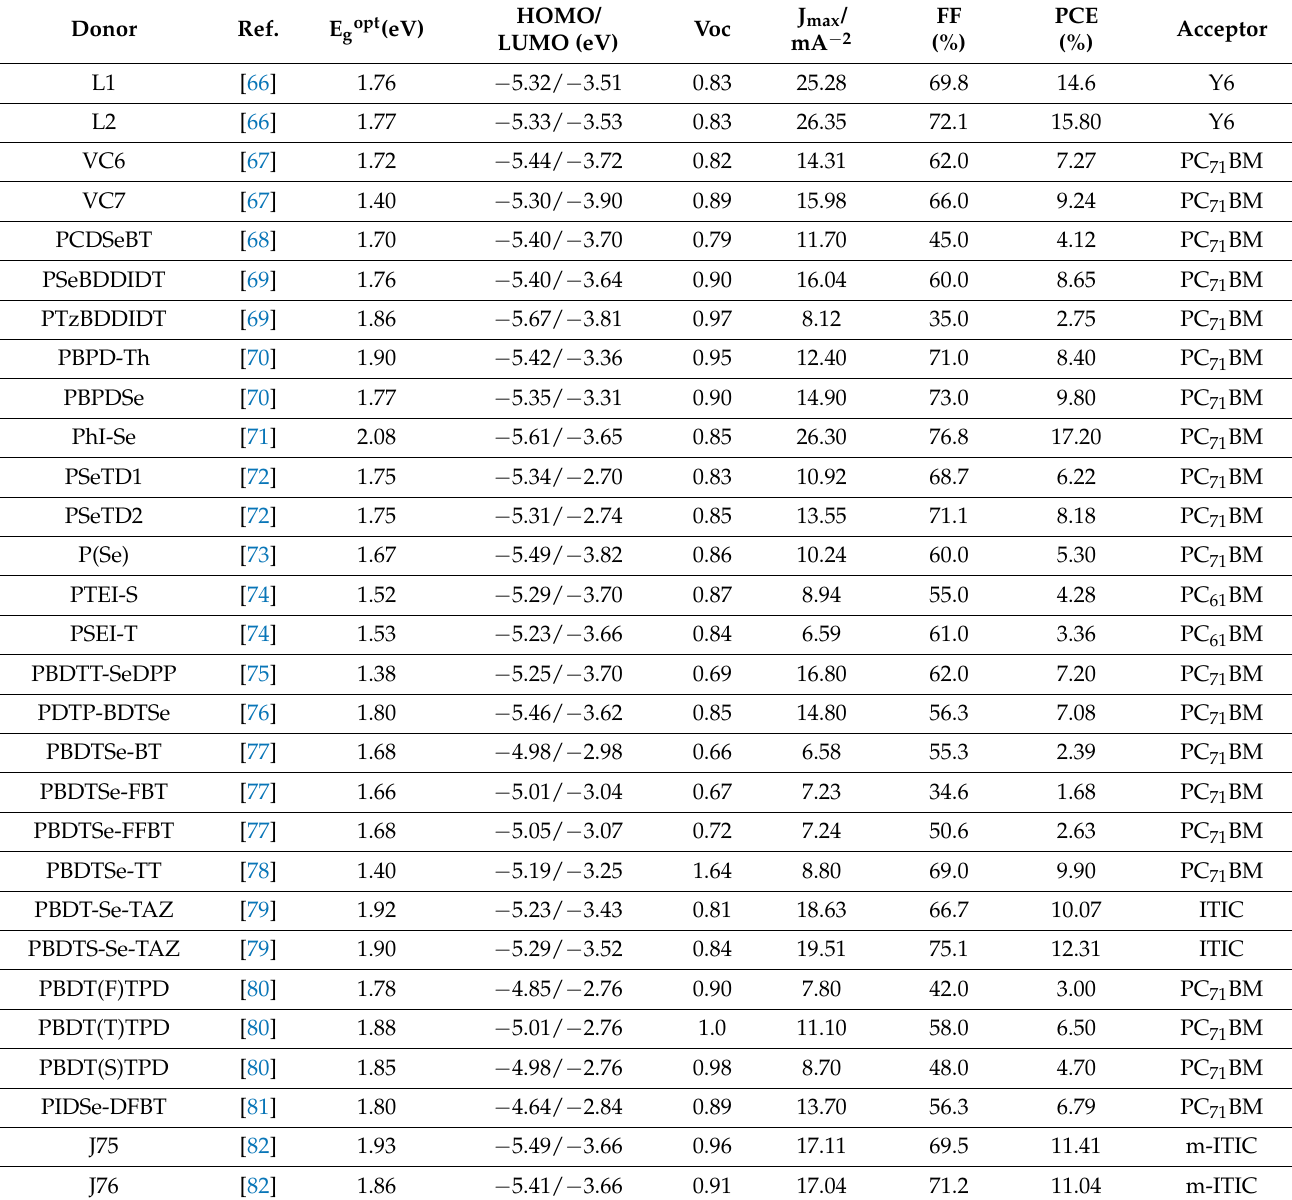
Table 2. OSC device parameters of selenophene